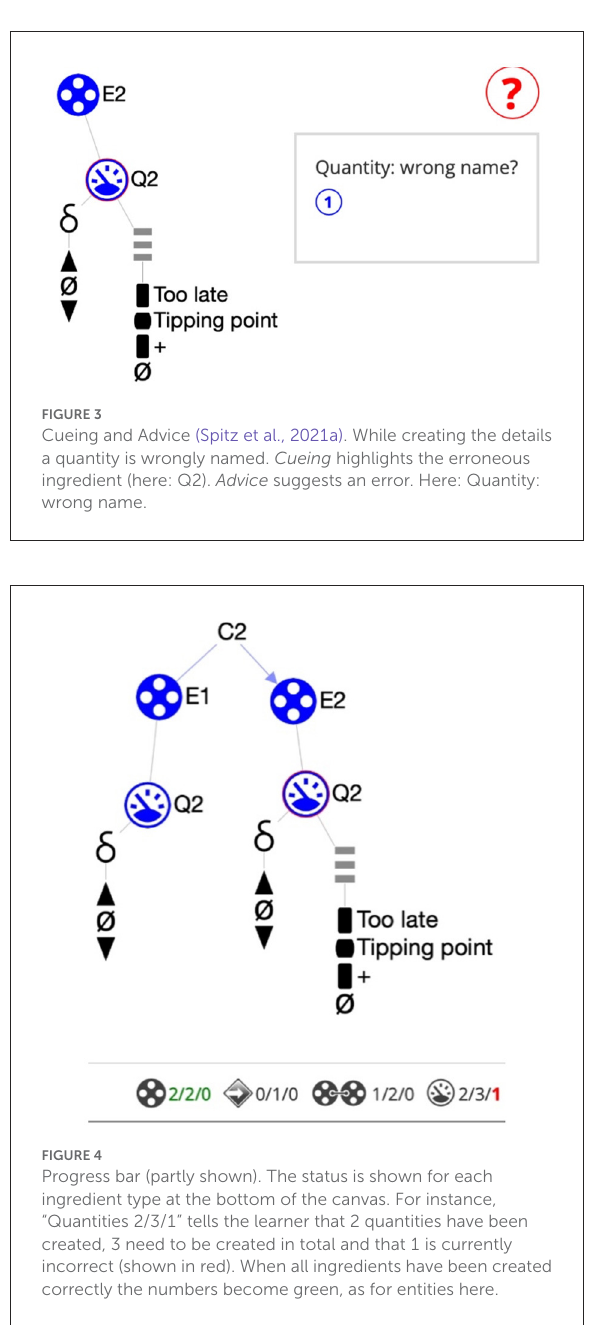
feedback. Cueing : a small red circle is placed around each deviating ingredient (Q2 in Figure 3) and a red question mark appears on the right-hand side in the canvas. Advice : when clicking on the question mark, a message-box appears showing a sentence for each deviation (in Figure 3: Quantity: Q2: wrong name?). Note that, the algorithm works domain independent, yet learners get subject specific information. For instance, whether they assign the correct quantities to each of the